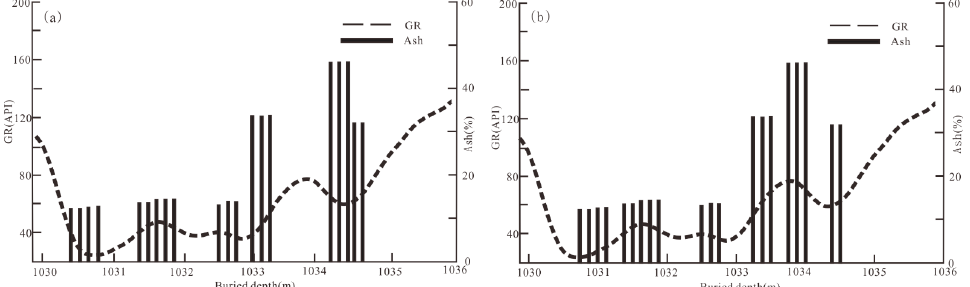
Figure 3. Comparison chart of before ( a ) and after ( b ) depth matching between coal core samples ash content and natural gamma (GR) log data (No. 11 seam of well C04).